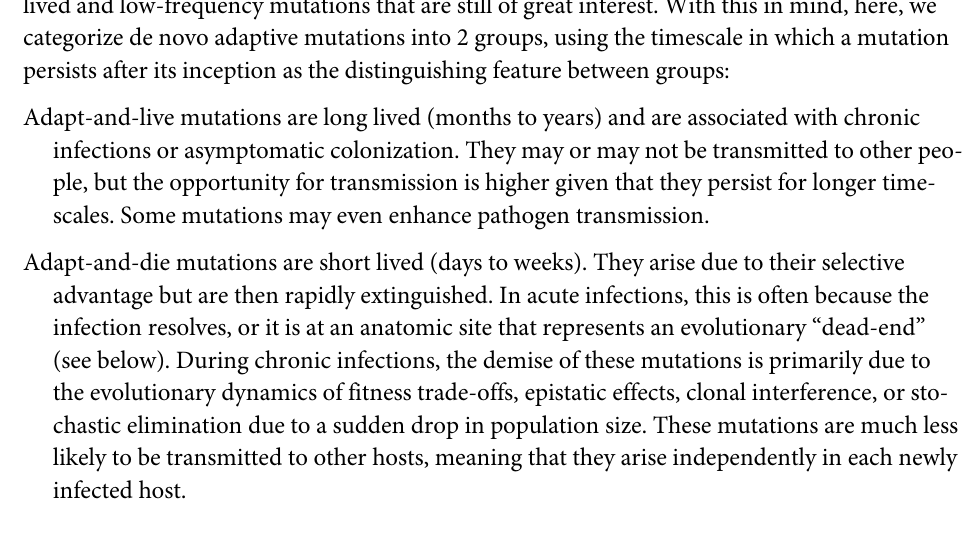
Fig 1. In vitro versus in vivo bacterial evolution. Comparison of parameters that differ between bacterial evolution in vitro (flasks) and in vivo (people). HGT, horizontal gene transfer; PK/PD,